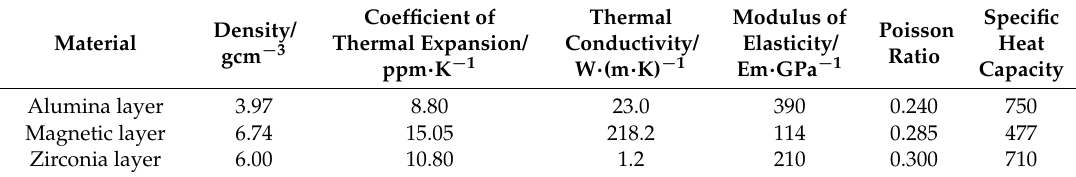
Table 4. Material parameters of the model with a single layer.